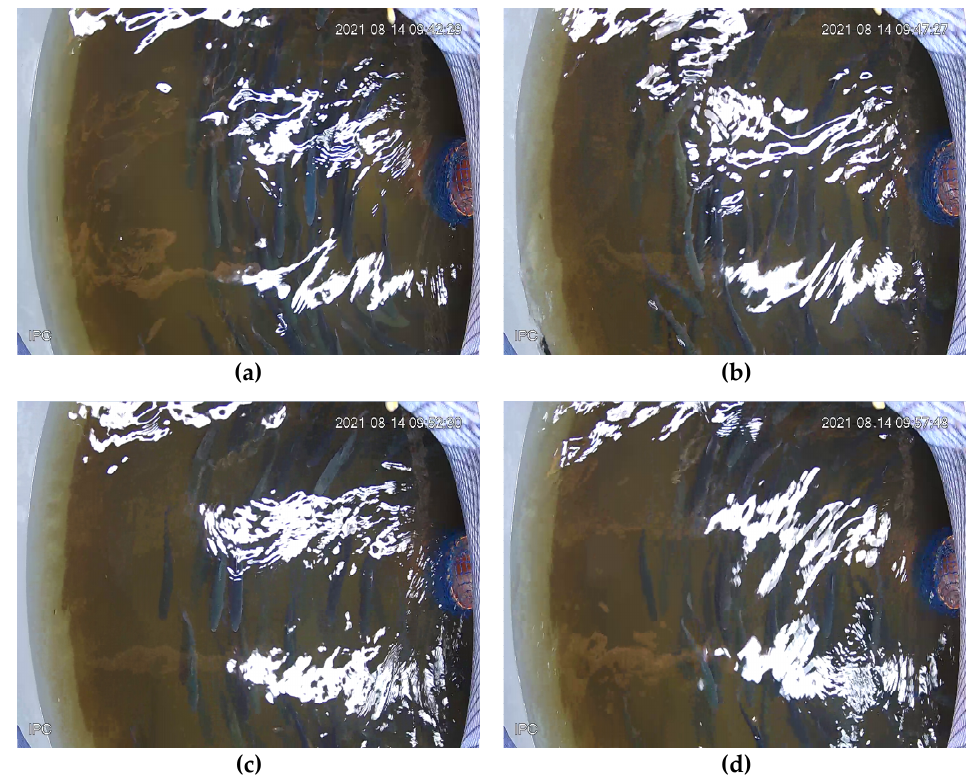
Figure 3. Sample video frames acquired for various measured water flow velocities in the presence of fish: ( a ) 2.35 dm 3 /s; ( b ) 2.99 dm 3 /s; ( c ) 3.62 dm 3 /s; and ( d ) 4.01 dm 3